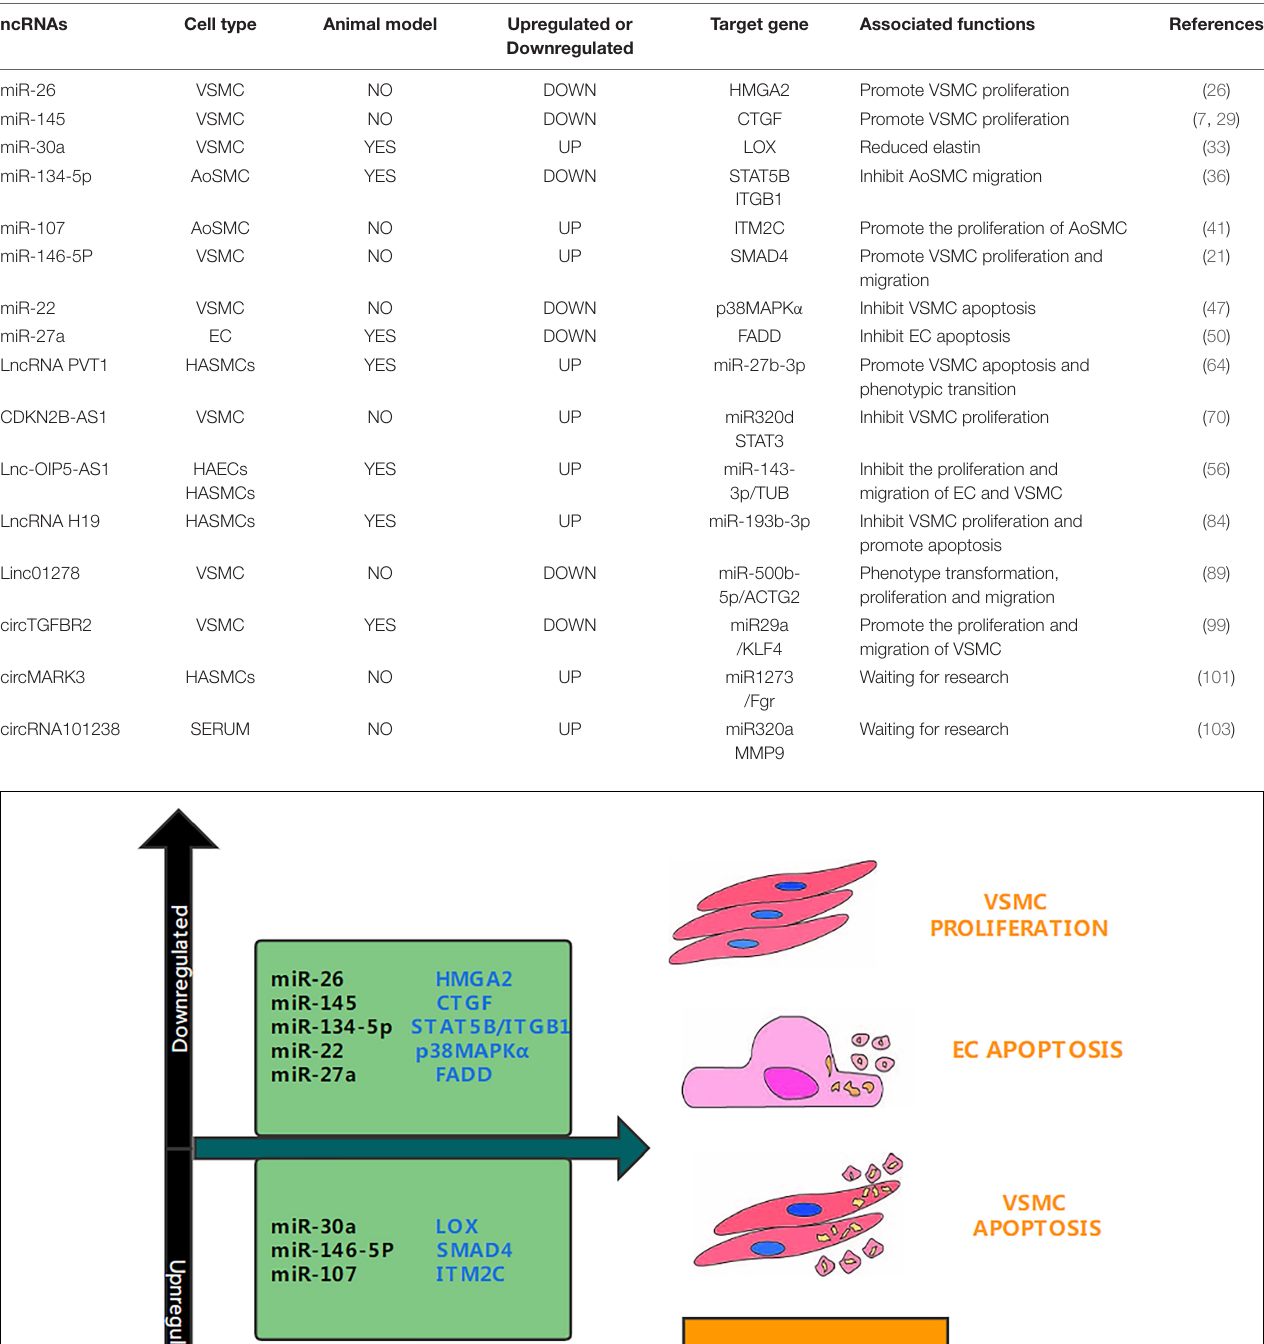
Frontiers in Cardiovascular Medicine |